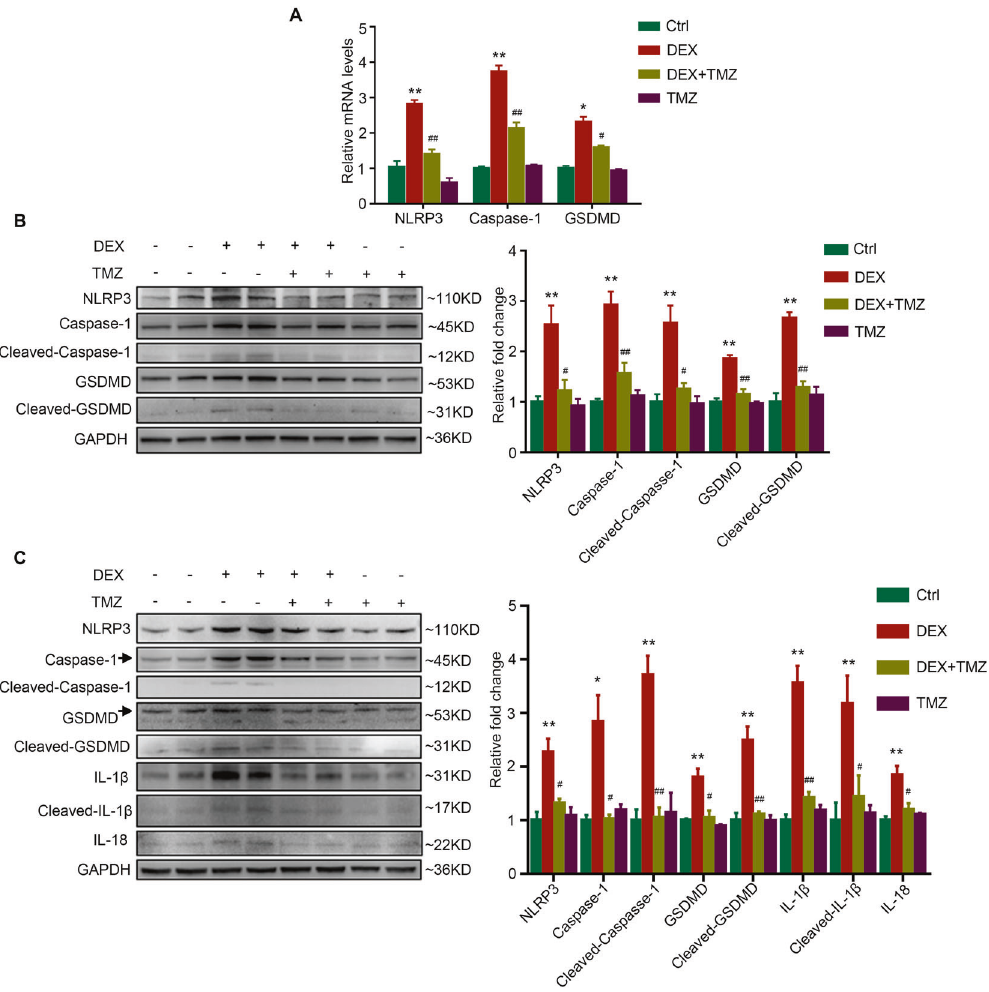
Cleaved-Caspase-1, GSDMD, and Cleaved-GSDMD. n = 4 per group. C Mice were intraperitoneally injected with 0.9% saline (Ctrl), DEX (25 mg/ kg), TMZ (5 mg/kg), or DEX (25 mg/kg) + TMZ (5 mg/kg) for 10 days. Protein levels of NLRP3, Caspase-1,